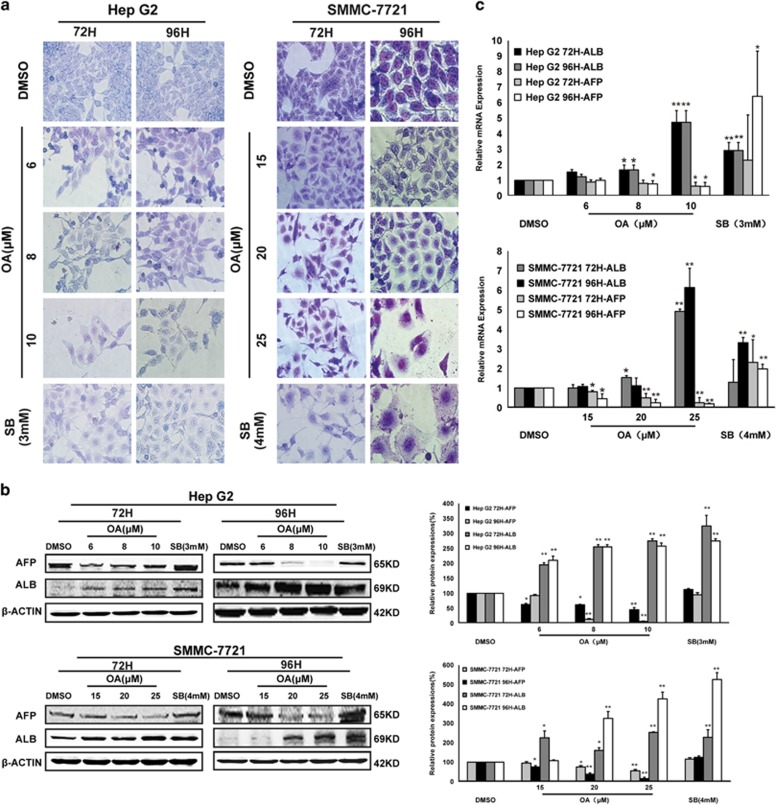
OA-induced differentiation of HCC cells. (a) Cell morphologic changes of HepG2 and SMMC-7721 cells by Giemsa staining. (b) The whole-cell lysates were prepared and subjected to WB for AFP and ALB. (c) Real-time quantitative PCR of AFP and ALB. Bars, SD. *P<0.05 or **P<0.01 versus DMSO-treated cells